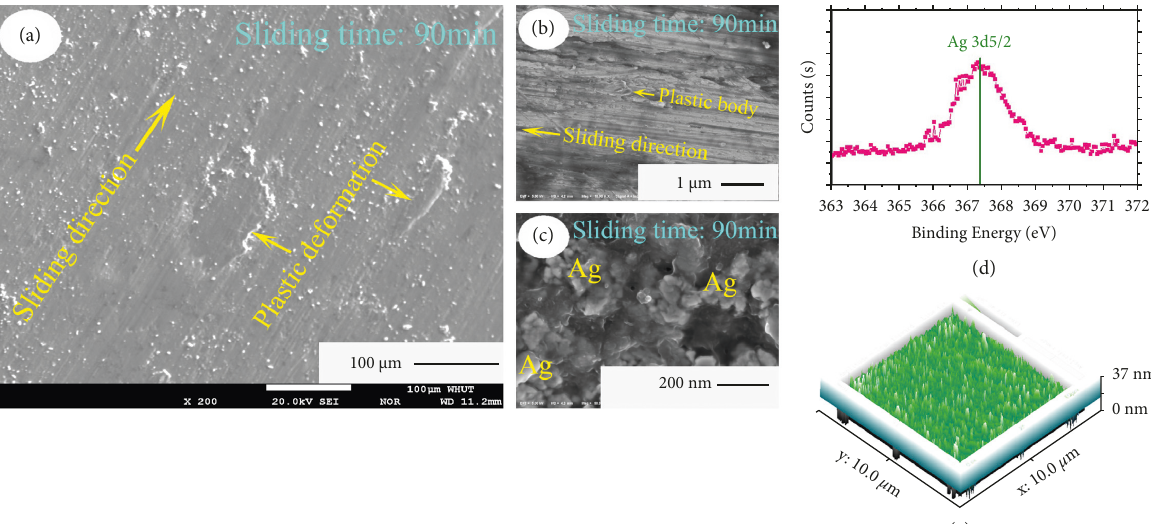
Figure 9: Typical EPMA morphology (a), FESEM morphologies (b, c), XPS result of silver (d), and AFM texture (e) on the wear scar at